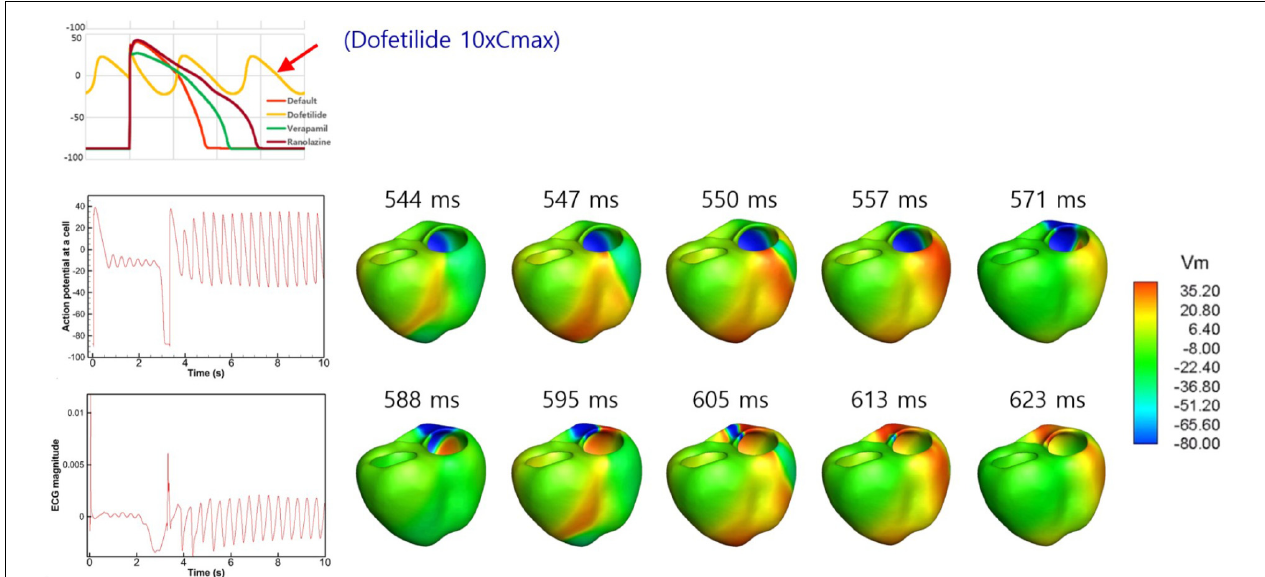
FIGURE 6 | Drug-induced ventricular tachycardia. The action potential from the single-cell model, action potential at a point in the 3D model, and ECG data from the 3D model in the presence of dofetilide at a Cmax value of 10 × are shown. Photographs of ventricular action potential propagation are also